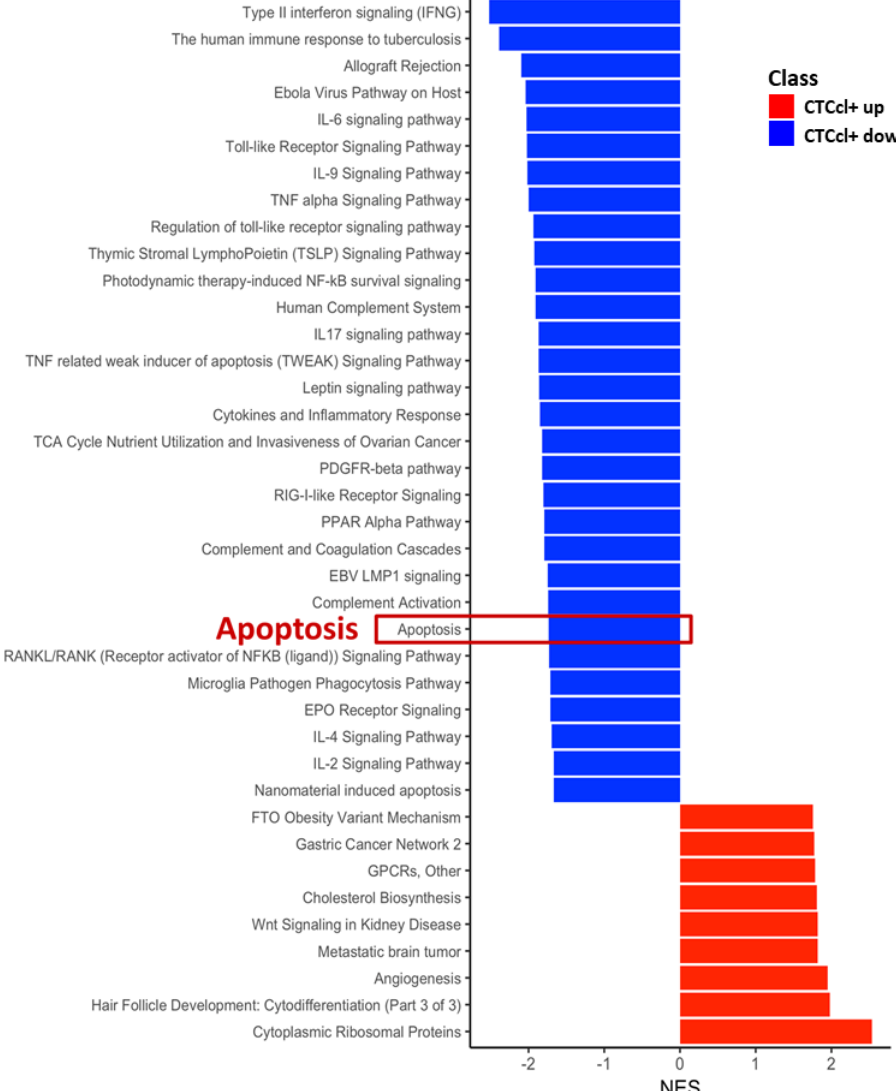
Figure 3. Pathway analysis showing apoptosis as one of the downregulated pathways in CTCcl+ samples. A total of 39 enriched pathway terms were identified with p -value < 0.05 and a false discovery rate (FDR) q -value < 0.1, and the enrichment score was given as normalized enrichment score (NES).